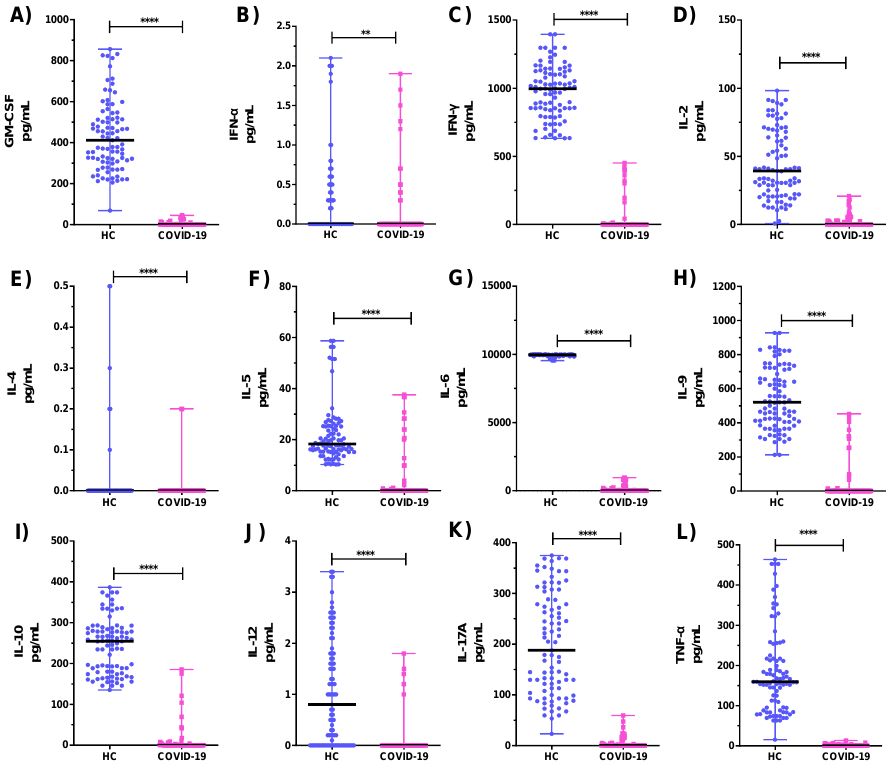
Figure 2. Cytokine profiles of neutrophils from healthy subjects and patients in the COVID-19 intensive care unit ( A – L ). ** p < 0.01, **** p < 0.0001 refers to the statistical differences. HC: healthy controls; ns: not significant. 3.3. Comparison of Cytokines Levels in Serum Samples of COVID-19 ICU Patients and Healthy Subjects (HC) Cytokine production profiles of serum samples from COVID-19 ICU patients and HC are shown in Figure 3. Statistically significantly lower mean values of serum levels of IFN- γ, IL-5, IL-12, and IL-17A were seen in COVID-19 ICU patients as compared to HC (Figure 3C, 3J, and 3K; p < 0.0001 Figure 3F, p < 0.01). In contrast, mean levels of GM-CSF, IFN- α, IL-2, IL-4, and IL-6 were higher in COVID-19 patients (Figure 3A; p < 0.001 Figure 3B, 3E, and 3G; p < 0.0001 Figure 3D; p < 0.01). No statistically significant changes were seen in the serum levels of IL-9 and IL-10 (Figure 3H, and 3I, p > 0.05).